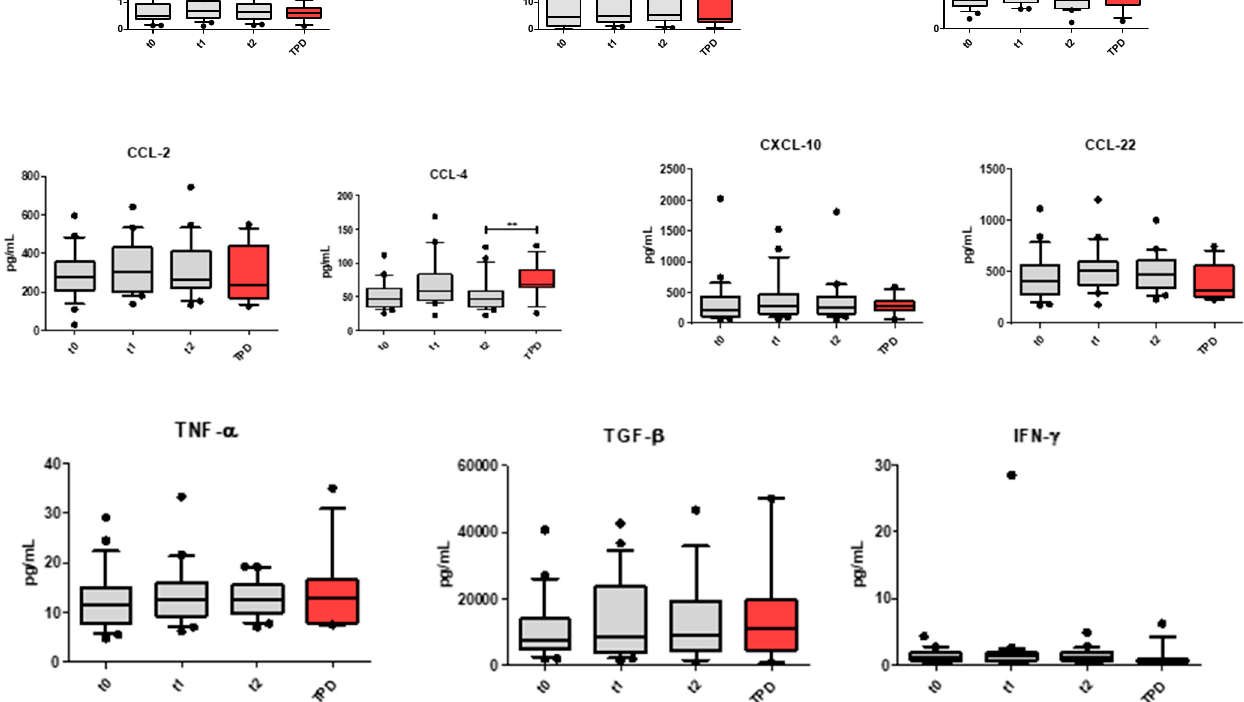
Figure 7. Distributions of cytokines among four time points: t0, t1, t2 (grey) and at disease progression (TPD; red). Only p values corrected for multiplicity are shown. ** p ≤ 0.01.